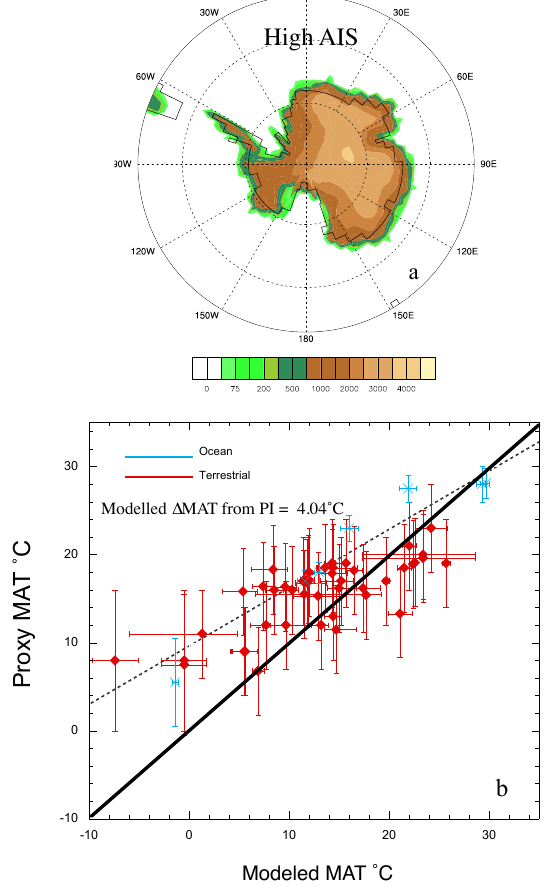
Fig. 2. (a) High AIS topography (meters) used in Herold et al. (2011), (b) pointwise MAT comparison between the MMCO Figure 1. a) High AIS topography (Herold et al., 2011), c) Pointwise MAT comparison between the MMCO simulation and proxy records (Table S1,S2). Vertical error bars are the modelled pointwise simulation and proxy records (Tables S1, S2). Horizontal error bars maximum and minimum temperatures from the extreme obliquity simulations (see Methods section) and are the modeled pointwise maximum and minimum temperatures methodological error is plotted as the horizontal error bars. The best fit line (black dashed) is weighted from the extreme obliquity simulations (see Methods Sect. 2.3) and to include error uncertainty and is fitted across all points. The y-intercept and slope are reported in Table 1. methodological error is plotted as the vertical error bars. The best fit line (black dashed) is weighted to include proxy uncertainty and is fitted across all points. The weighting for each proxy record is calculated by 1/(error 2 ). The y intercept and slope are reported